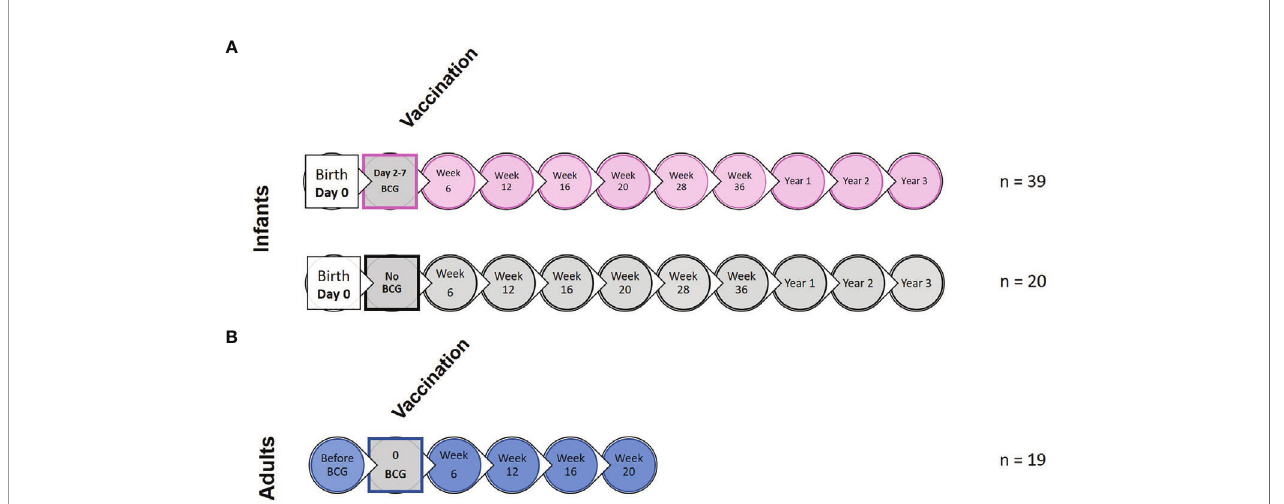
FIGURE 1 | Study timeline relative to BCG vaccination and immunological analysis. (A) shows the study timeline in which infant rhesus macaques received BCG delivered by intradermal injection (n = 39) within a week of birth (two to seven days after birth) or remained unvaccinated as controls (n = 20). (B) Young adult macaques aged between 3.7 and 5.2 years of age received BCG delivered by intradermal injection at study week 0 (n = 19). Circles represent points relative to vaccination at which clinical examinations were conducted and blood samples collected for application of immunological